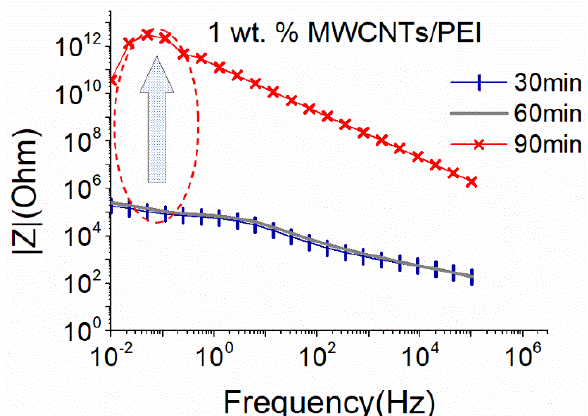
Figure 6. EIS plots of aqueous dispersion with 1% MWCNTs, using the big sonication probe at an amplitude of 25%, in the presence of PEI (18.6 W).